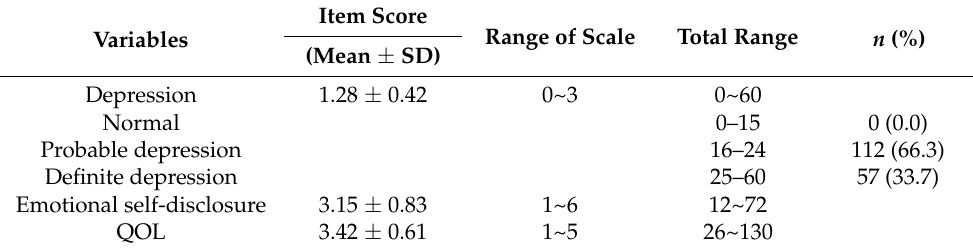
Table 2. Depression, emotional self-disclosure, and QOL of subjects ( n =